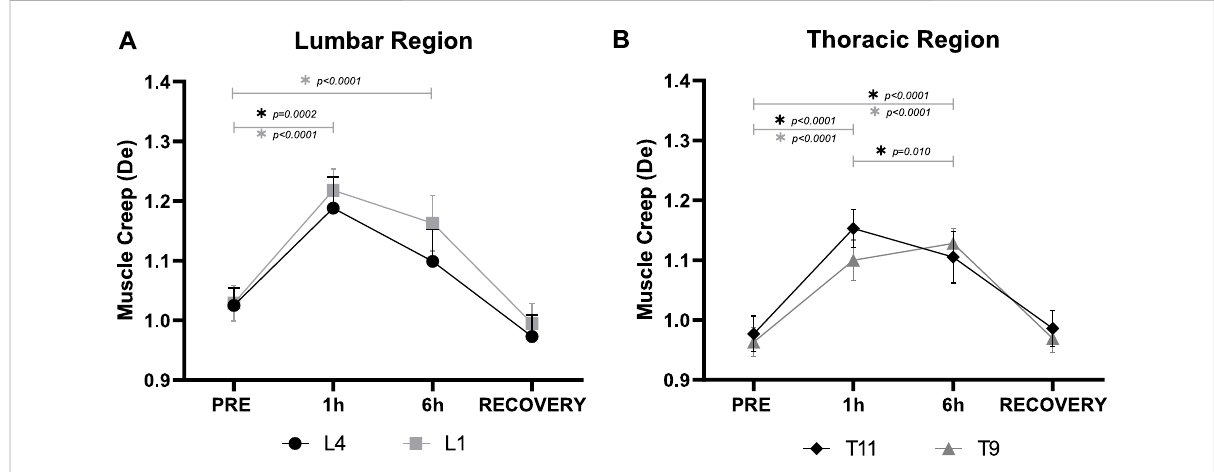
FIGURE 6 Mean (±SEM) bilateral m. erector spinae myofascial creep (De) in the (A) : Lower Lumbar (L4) and Upper Lumbar (L1), and (B) : Lower Thoracic (T11), and Middle Thoracic (T9) regions before (PRE), during Dry Immersion (DI) after 1 (1 h) and 6 (6 h) hours, and 30 min after being raised out of DI (RECOVERY). *Statistically signi fi cant difference ( p < 0.05) between time points (post-hoc Bonferroni corrected t -tests).